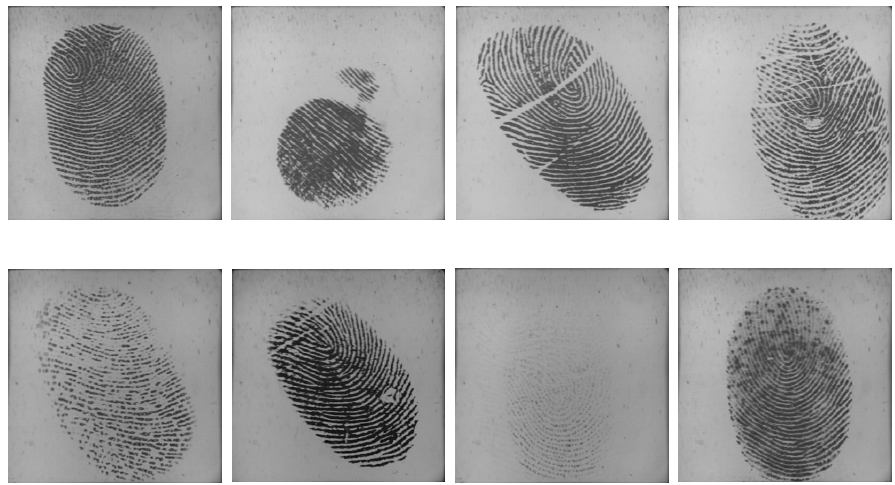
Figure 6. Sample fingerprint images in the SDU-FV database with various types and